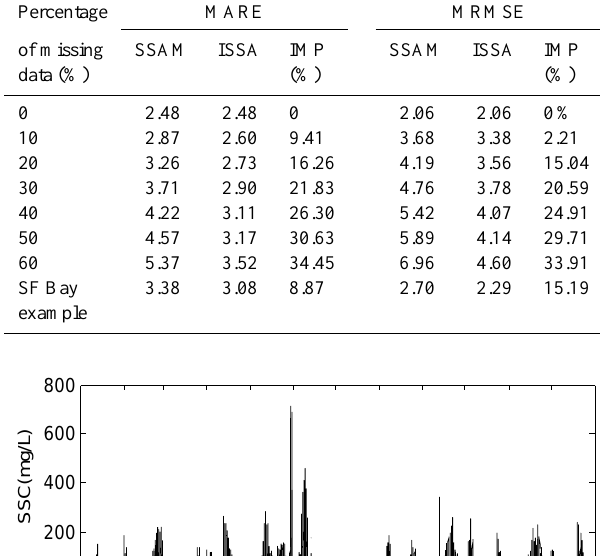
Table 1. Mean absolute reconstruction error and mean root mean squared error of simulated time series with different percentage of missing data (mgL − 1 ).